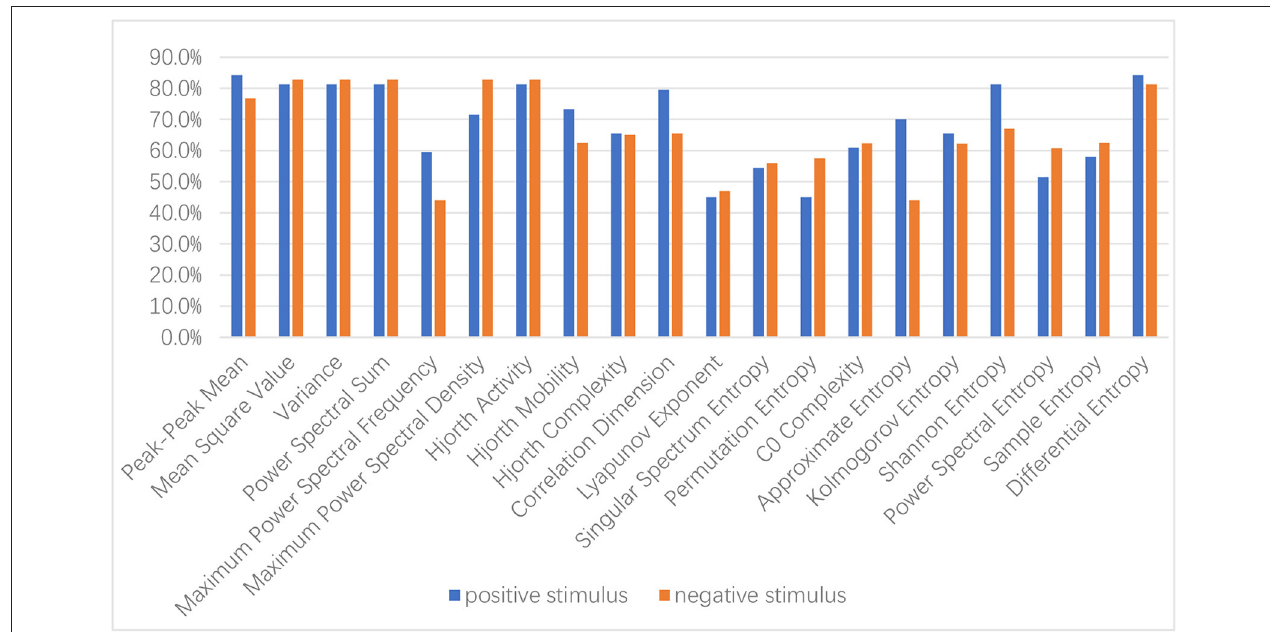
FIGURE 3 | Performance comparison of different handcrafted features for typically developing (TD)/autism spectrum disorder (ASD) classification.